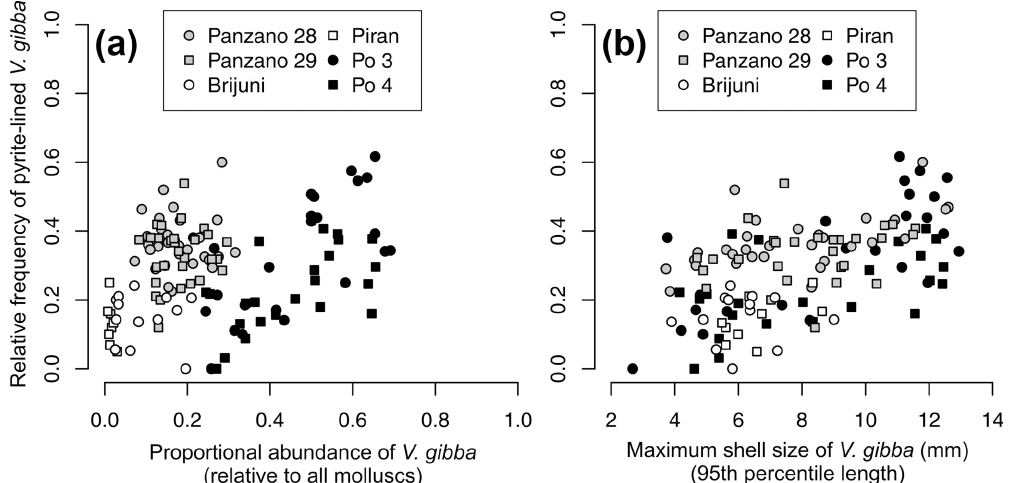
Figure 15. (a) The relationship between the frequency of V. gibba valves lined by pyrite framboids and V. gibba proportional abundance per increment is positive at the Po stations (black symbols). Within-site relationships are positive whereas regional-scale relationships are more heterogeneous and noisy owing to between-site differences in time averaging. (b) The relationship between the frequency of V. gibba valves lined by pyrite framboids and V. gibba maximum shell size per increment is positive within all sites. These relationships are interpreted to reflect the response of ecological and taphonomic processes as responding together to higher hypoxia frequency and a narrower extent of aerobic respiration in sediment (but with continuing bio-mixing), possibly reducing bioirrigation during the prolonged recovery, leading to smaller food and space limitation and thus to higher abundance and size of V. gibba in the wake of hypoxic events and simultaneously to a higher frequency of pyrite